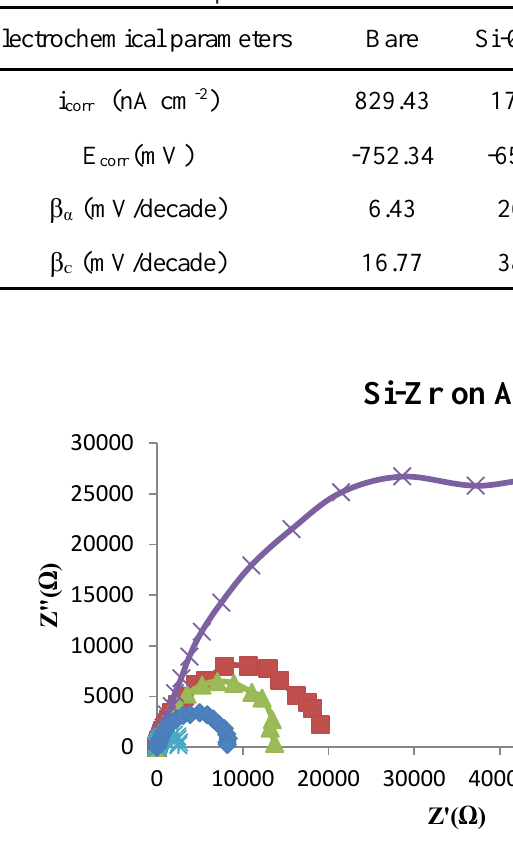
Figure 3. Nyquist plots of bare sample, Si coating and Si/Zr nanocomposite coating with different amounts of